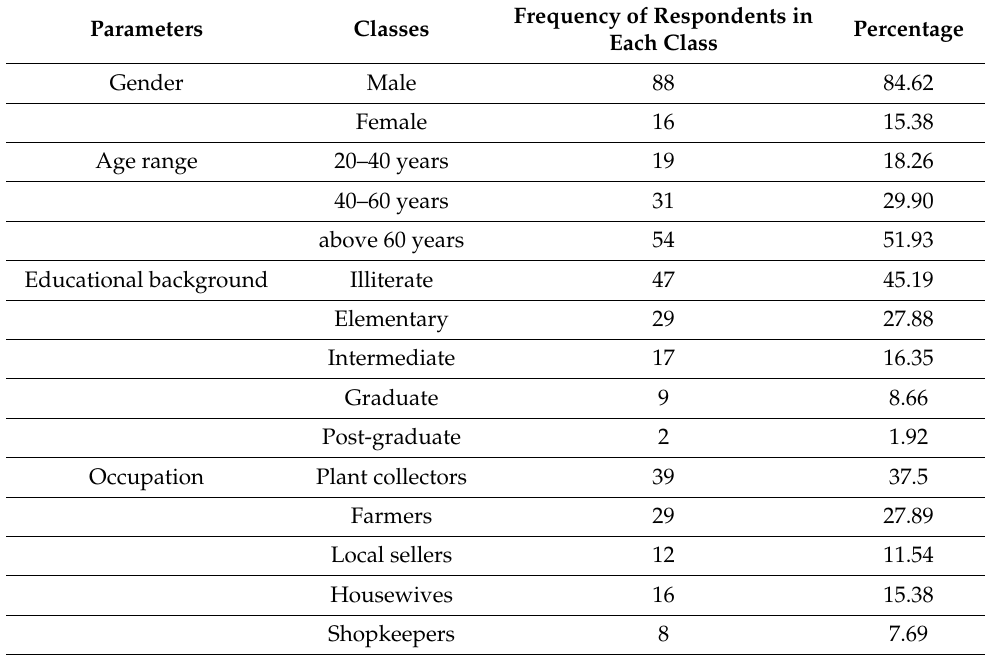
Figure 1. Map of the study area and visited villages. Table 1. Demographic characteristics of the study